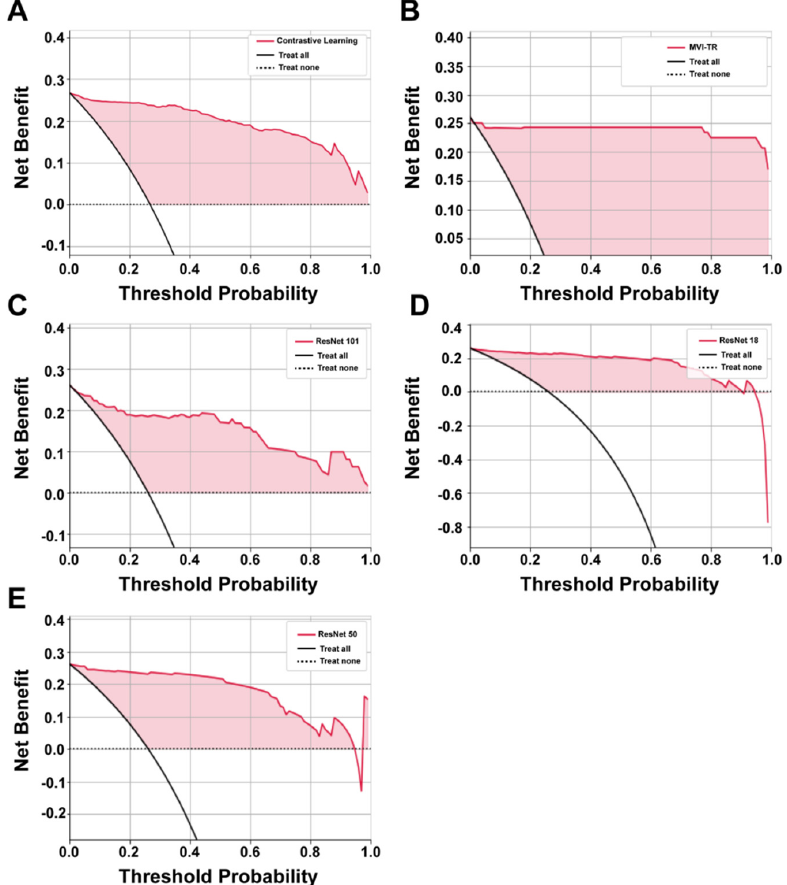
Figure 5. The decision curve analysis ( DCA ) curves of 5 different models. ( A − E ) Show the DCA curves of contrastive learning, MVI-TR, ResNet101, ResNet18, ResNet50, respectively.